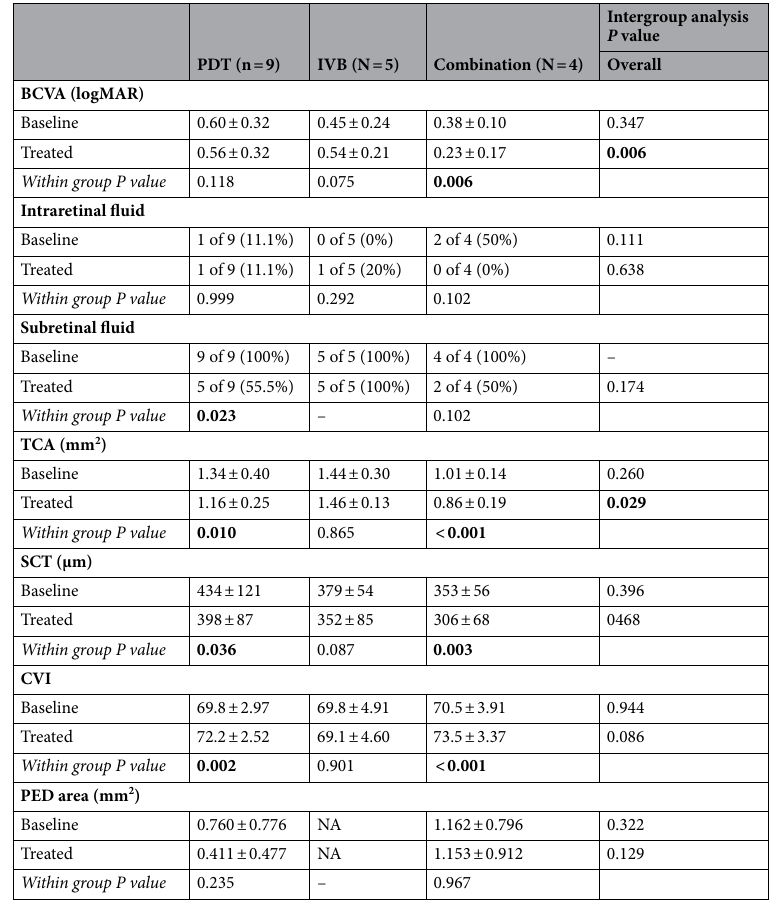
Variables Baseline values B (confidence interval 95%) P value